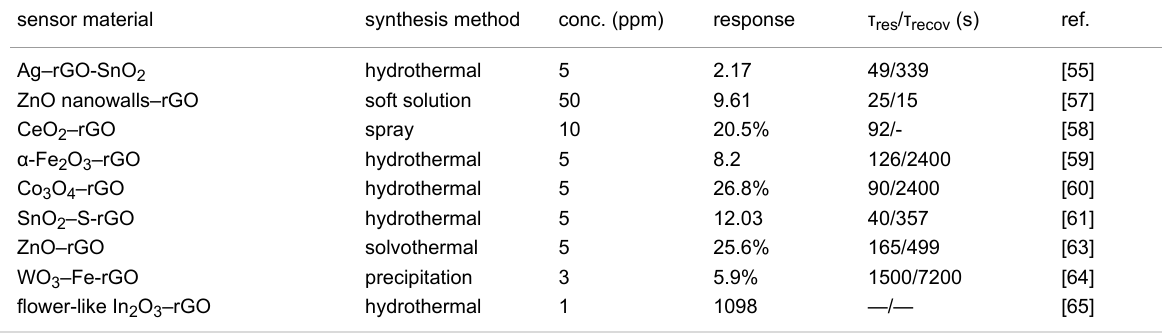
Table 2: NO 2 sensing performance of graphene/metal-oxide sensors at room temperature. sensor